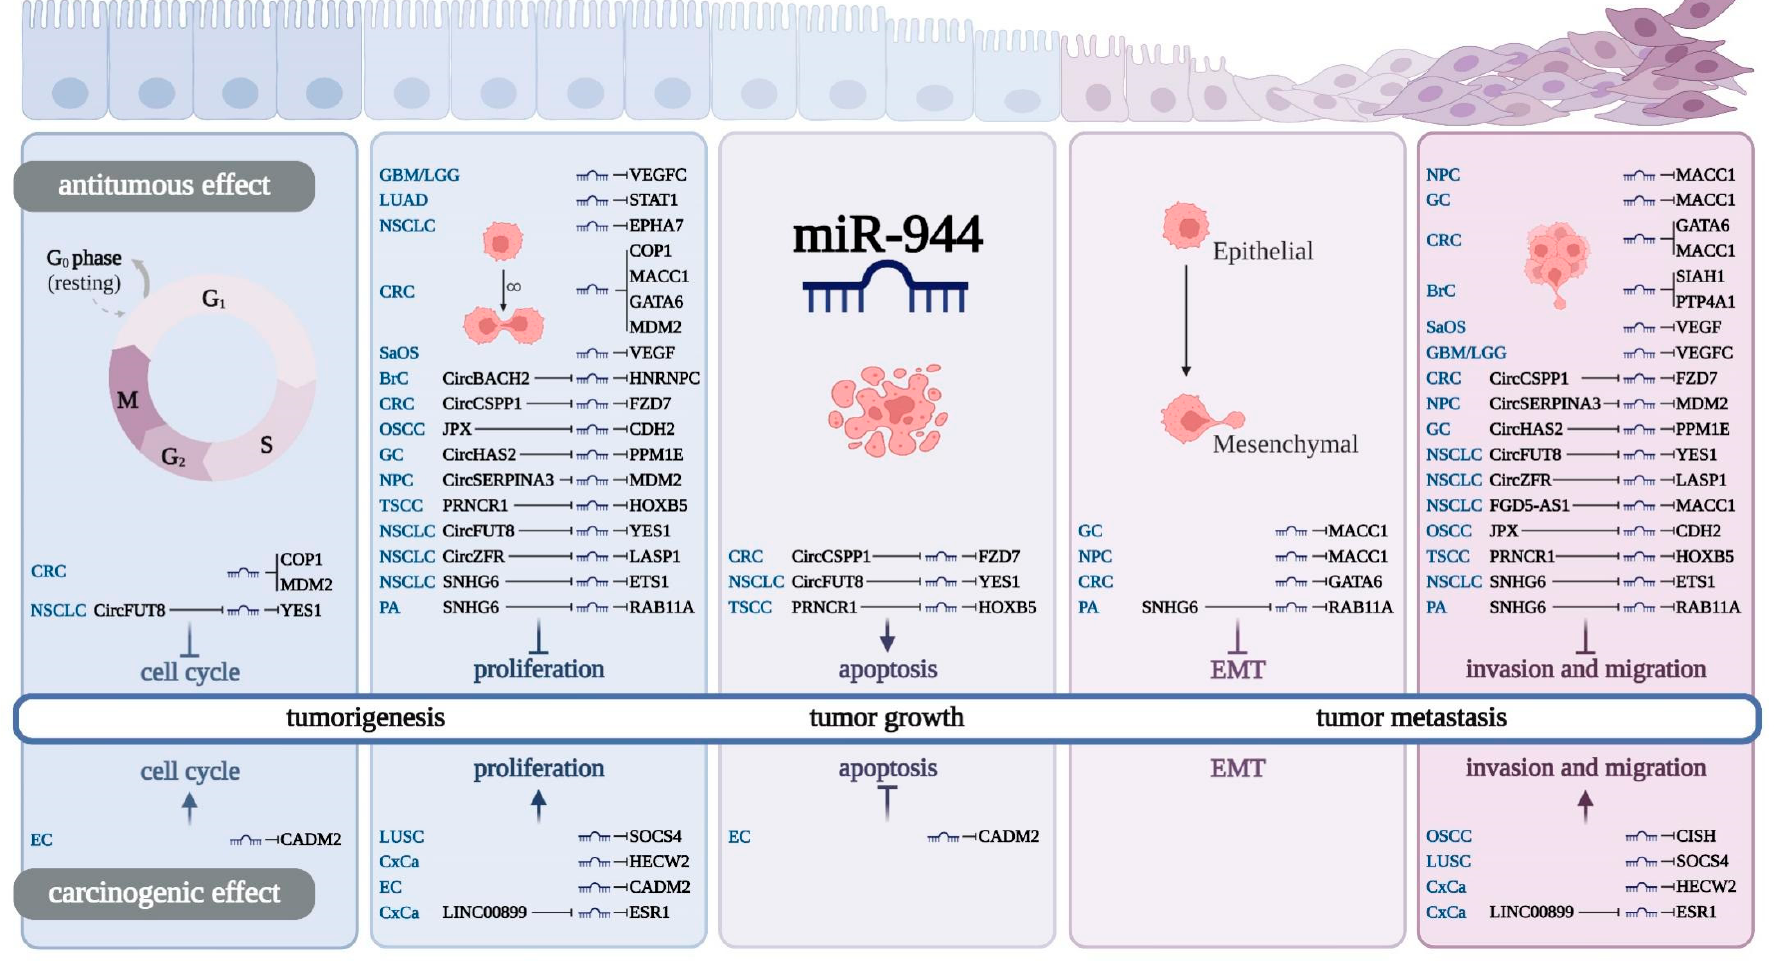
Figure 3. miR-944 and the regulation of cancer cell behaviors. miR-944 can regulate a variety of cancer cell biological behaviors through its ceRNA networks or target genes.